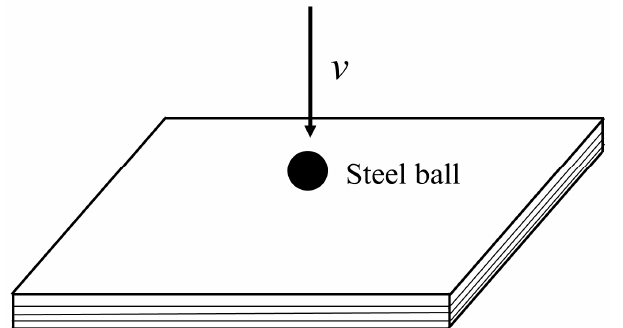
Figure 9. Geometric model of the laminate subjected to steel ball impact loading.